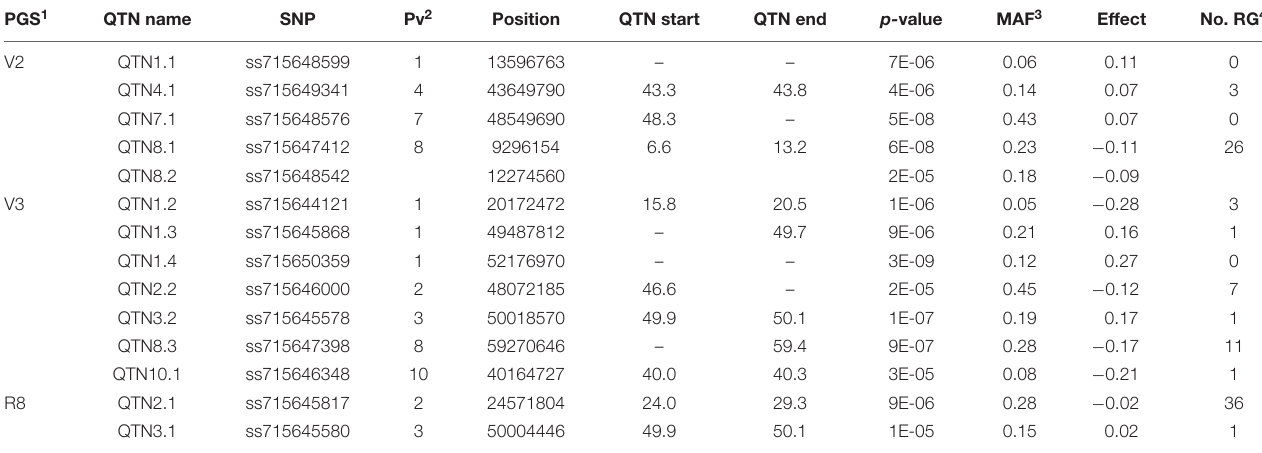
FIGURE 3 | (A) Manhattan-plots, QQ-plots, and histograms for GWAS analyses using the carioca diversity panel genotyped by 1,979 SNPs and evaluated for resistance to angular leaf spot disease in the V2 (A) , V3 (B) , and R8 (C) plant growth stages. Regions with more than one significant SNPs for one or more stages are delimited by the blue dashed line. The threshold defined by the Bonferroni (cutoff α = 0.05) test and by the 1,000 permutations are plotted in red and green, respectively. TABLE 5 | GWAS results: Significant SNPs for association mapping using the carioca diversity panel evaluated phenotypically for resistance to angular leaf spot in the V2, V3, and R8 plant growth stages. The effective size of each QTN (start and end) was determined by the interval size of the haplotype blocks containing the markers in